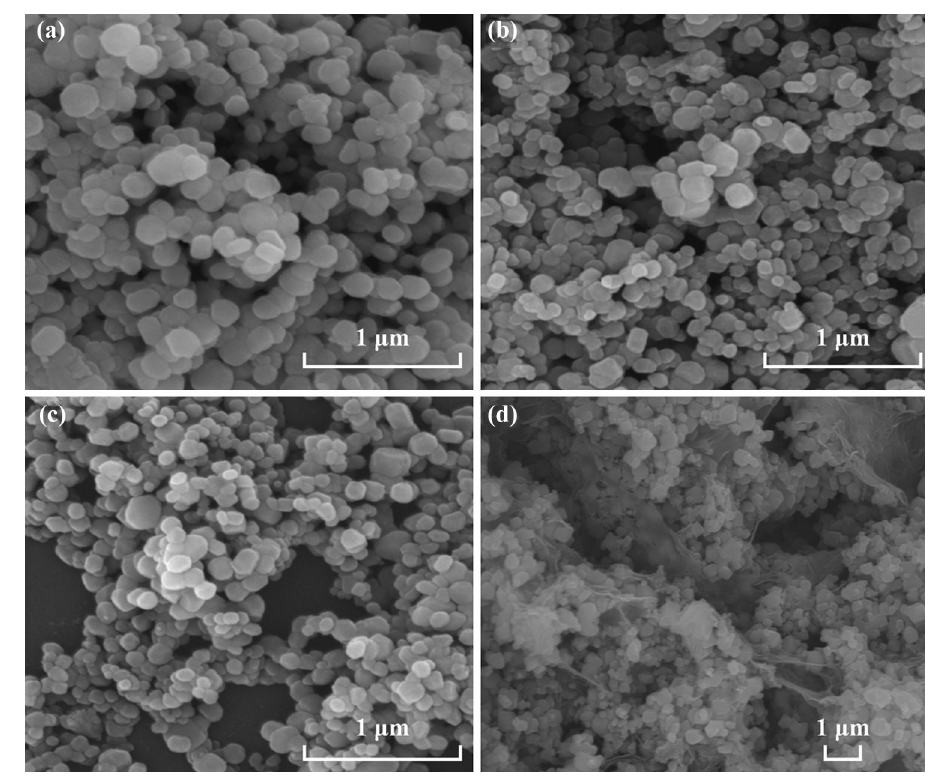
Fig. 2 SEM images with different magnifications of a , c CCO nanoparticles, b , d CCO@rGO nanocomposites